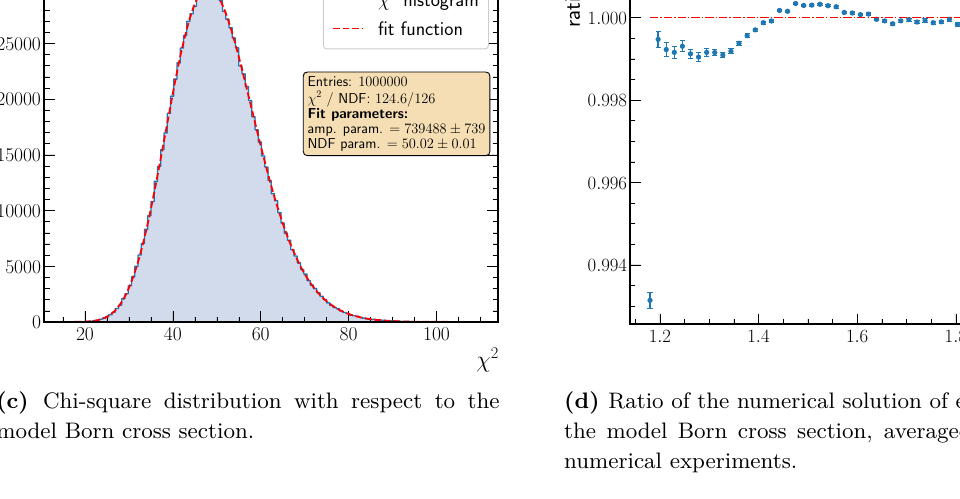
Figure 15. Results of the numerical experiment with the e + e − → ηπ + π − cross section obtained using the naive method with a detection efficiency equal to